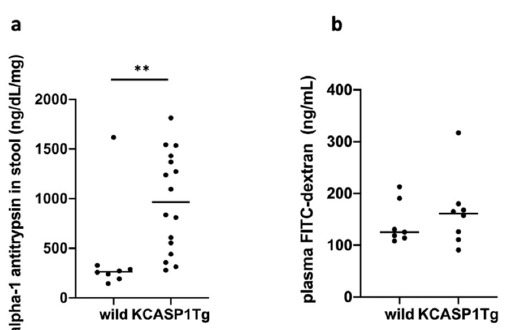
Figure 3. Gastrointestinal tract barrier function. ( a ) α 1 ‐ antitrypsin in feces was significantly more in the KCASP1Tg mice than in the WT littermates ( n = 6 per group). ( b ) However, intestinal permea